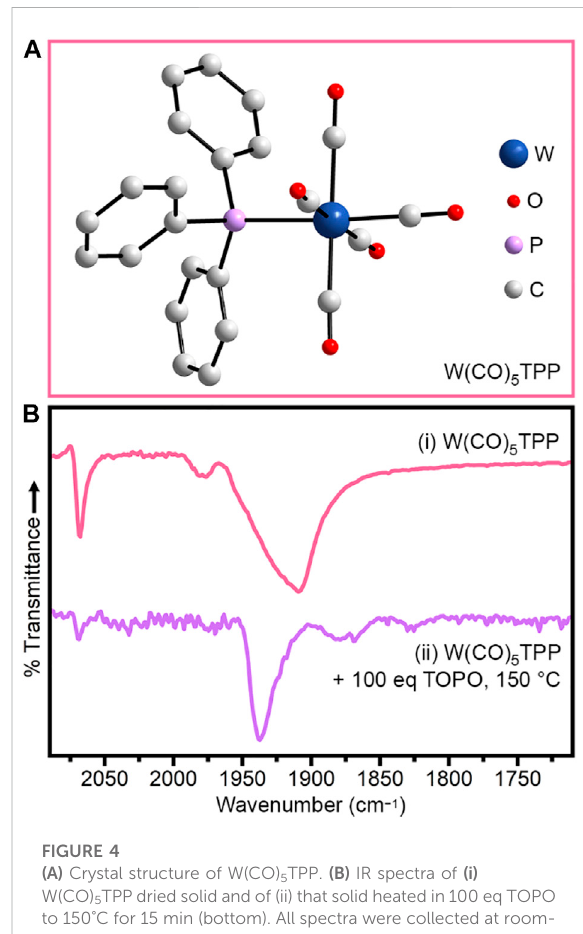
FIGURE 4 (A) Crystal structure of W(CO) 5 TPP. (B) IR spectra of (i) W(CO) 5 TPP dried solid and of (ii) that solid heated in 100 eq TOPO to 150 ° C for 15 min (bottom). All spectra were collected at room-